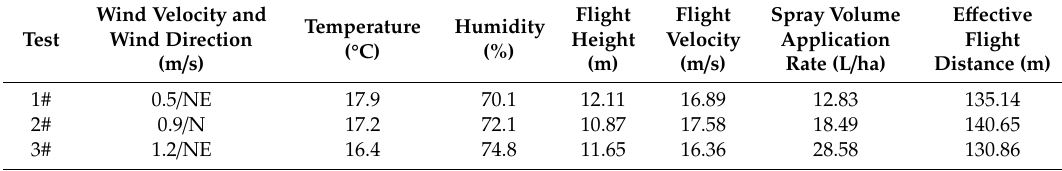
Table 5. Summary of meteorological data and flight parameters for each test.